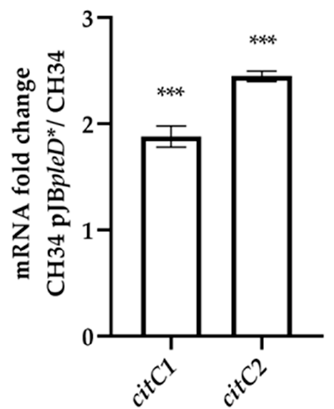
Figure 3. C. metallidurans CH34 pJB pleD * showed increased levels of c-type cytochrome-associated transcripts compared with the wild-type strain CH34. Each bar represents the mean ratios from one biological replicate analyzed by technical quadruplicates using rpoZ and gyrB as reference genes. Fold change significances were assessed by a one-sample t -test: ***, p <